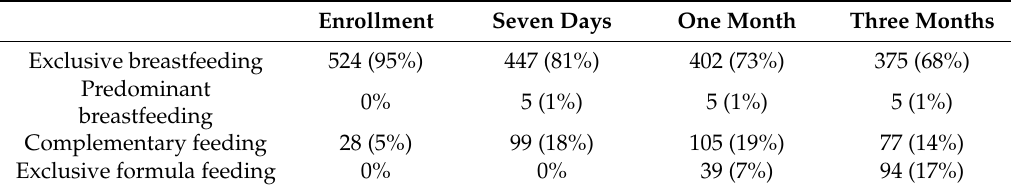
Table 2. Mode of feeding at each time point of the study.